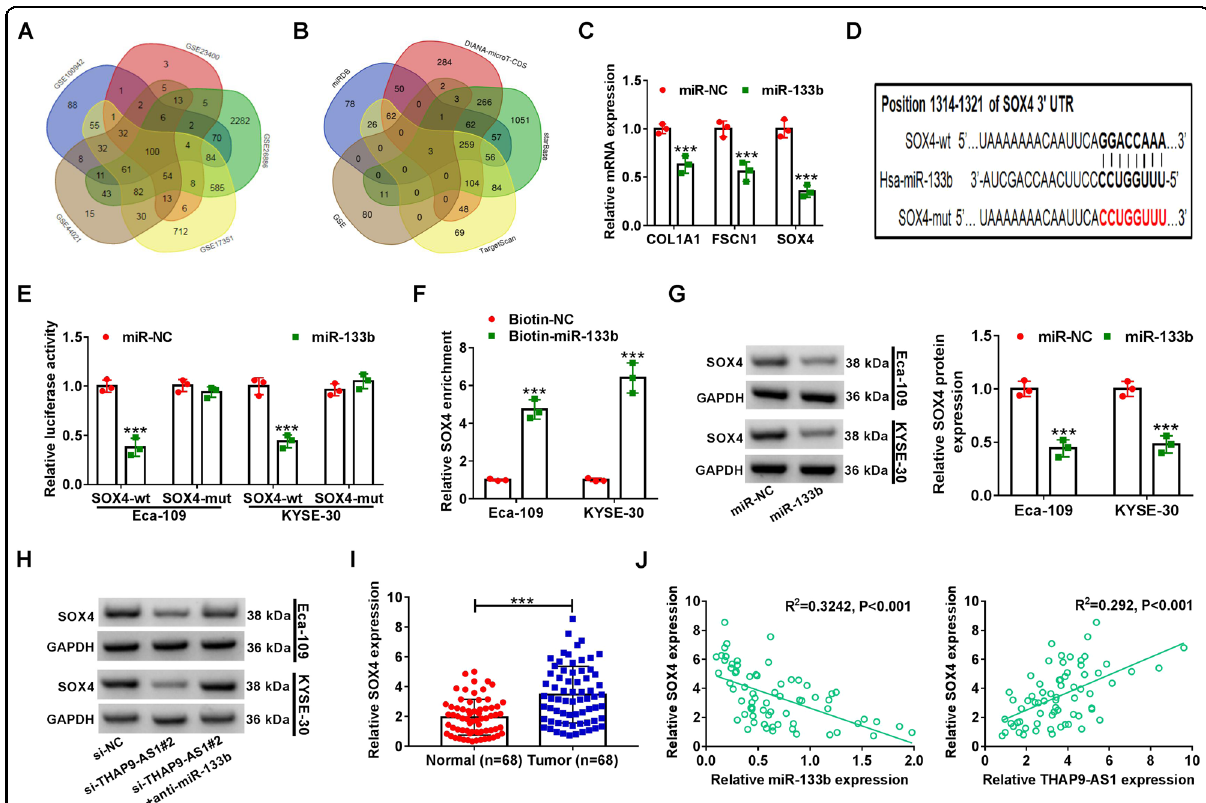
Fig. 5 THAP9-AS1 increases SOX4 expression through competitively binding to miR-133b in ESCC cells. A A total of 100 upregulated genes were identi fi ed in ESCC from 5 different ESCC patient cohorts (GSE100942, GSE23400, GSE26886, GSE17351, GSE44021) based on the criteria of log2 fold change ≥ 1. B Using 4 freely available databases (TargetScan, miRDB, DIANA-microT-CDS, starBase), three genes (COL1A1, FSCN1, and SOX4) that contain the potential binding sites of miR-133b were fi ltered out among these 100 upregulated candidates. C qRT-PCR was used to uncover the effect of miR-133b overexpression on the mRNA level of SOX4, FSCN1, and COL1A1 in Eca-109 cells. D The wild-type complementary sequences of SOX4-3 ′ UTR on miR-133b and corresponding mutant sequences were shown. E Dual-luciferase reporter assays were performed in both Eca-109 and KYSE-30 cells after cotransfection with miR-NC or miR-133b and SOX4-wt or SOX4-mut reporter. F Biotinylated RNA pull-down assays were used to demonstrate the binding between miR-133b and SOX4. G Western blot assays were used to measure the protein expression of SOX4 in miR-NC- overexpressing or miR-133b-overexpressing ESCC cells. H The protein level of SOX4 was determined by western blot in Eca-109 and KYSE-30 cells transfected with si-NC, si-THAP9-AS1#2, or si-THAP9-AS1#2 + anti-miR-133b. I Expression difference of SOX4 mRNA in tumor tissues and corresponding para-carcinoma tissues from a cohort of 68 ESCC patients. J Correlation analysis between SOX4 mRNA expression and miR-133b or THAP9-AS1 in 68 ESCC tumor specimens. *** P <